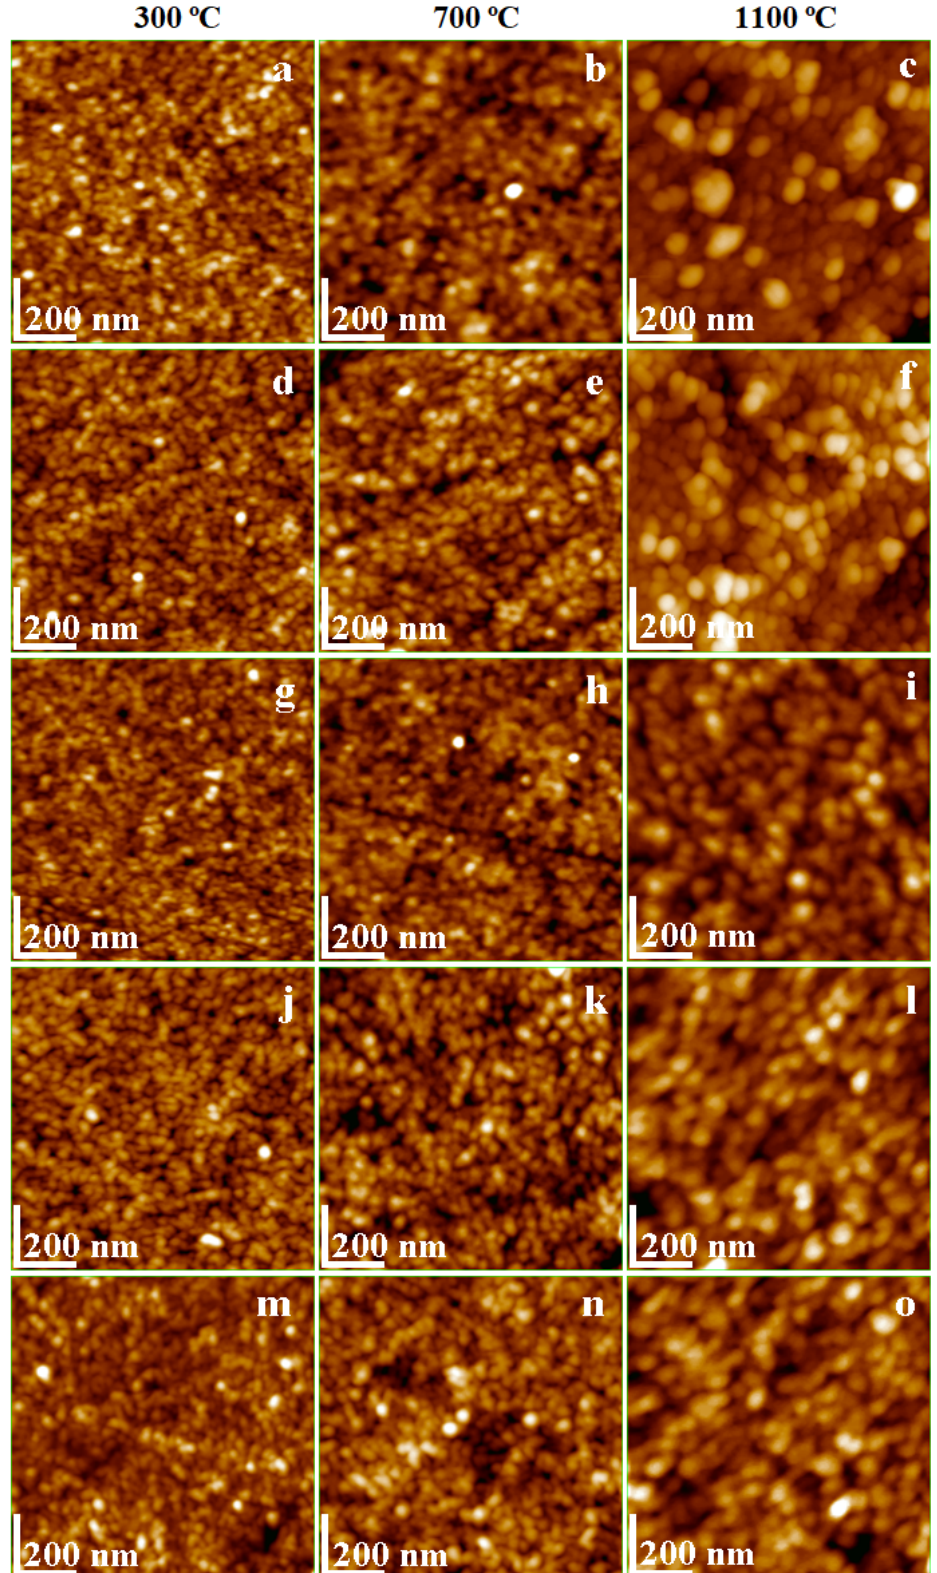
Figure 2. AFM topographic images of (Ni 0.6 Mn 0.4 Fe 2 O 4 ) α (SiO 2 ) 100 − α NCs, α 100% ( a , b , c ); α = 25% ( d , e , f ); α = 50% ( g , h , i ); α = 75% ( j , k , l ) and α = 100% ( m , n , o) calcined at 300, 700 and 1100 °C.